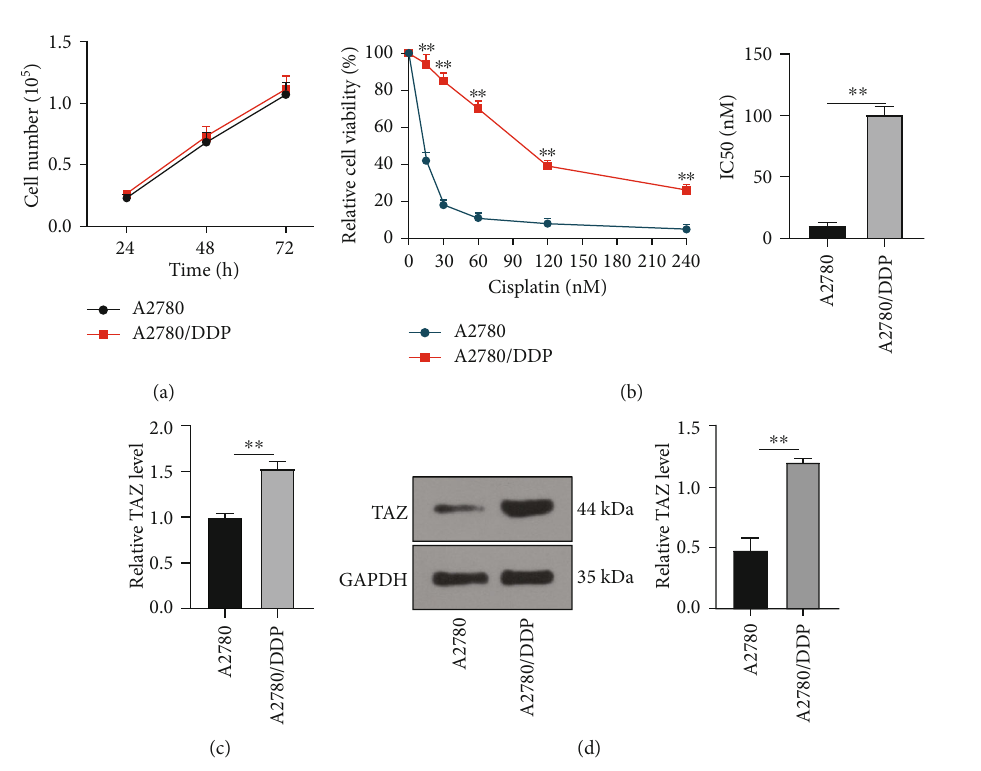
Figure 1: TAZ was highly expressed in drug-resistant EOC cells. The A2780/DDP cell models were established. (a) Cell viability was detected by CCK-8. (b) After EOC cells were treated with cisplatin at di ff erent concentrations for 48 hours, the drug sensitivity of EOC cells was detected by CCK-8. (c) TAZ mRNA expression was determined using RT-qPCR. (d) Protein expression of TAZ was measured via WB. Cell experiment was repeated three times. Data were expressed as mean ± SD , and independent sample t test was used for comparisons between the two groups. ∗∗ P < 0 : 01